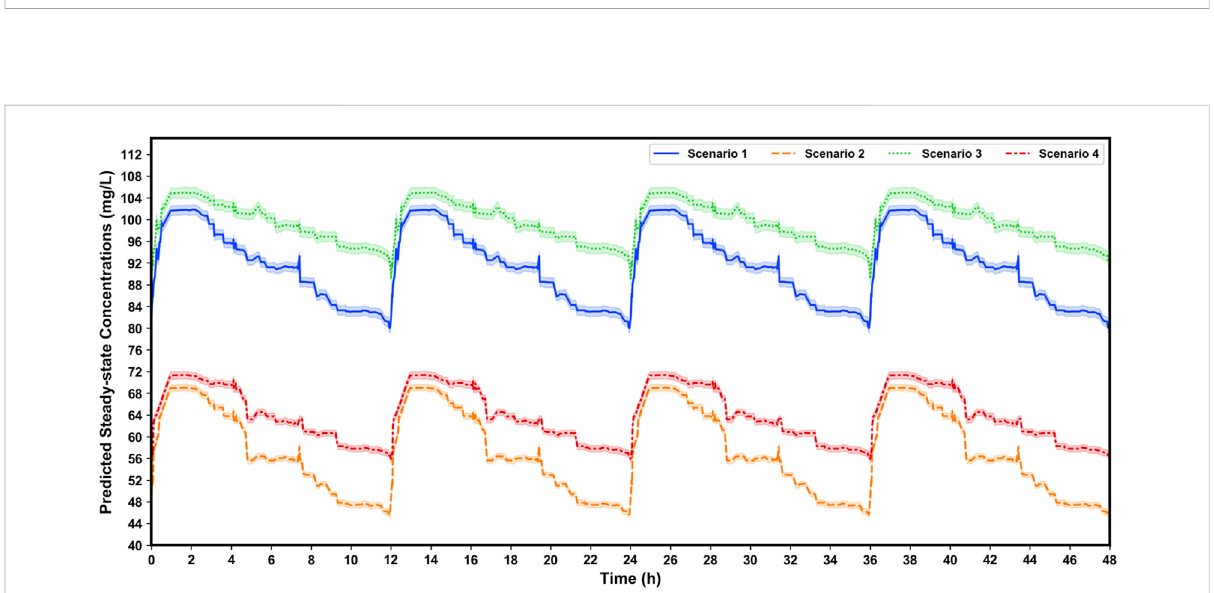
FIGURE 6 Simulated C ss of VPA plotted by using four dosing intervals at the dosage regimen of 500 mg/bid in different scenarios based on the proposed XGBoost model. The numbers of virtual patients at each time point is 1,000. The blue, orange, green, and red line denotes scenario 1 (patients with CYP2C19*2 and/or *3 variants, and taking co-administered CBZ + PHT + PB), scenario 2 (patients with CYP2C19*1*1 genotype, and taking co- administered CBZ + PHT + PB), scenario 3 (patients with CYP2C19*2 and/or *3 variants, and not taking co-administered CBZ, PHT, or PB),